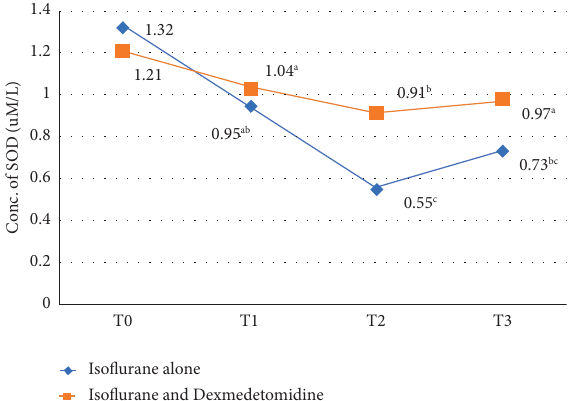
Figure 8: Comparison of enzymatic activity of SOD ( µ M/L) in group A and group B. T T 1 � at 4hours after anesthesia induction. T 2 � at 8hours of anesthesia induction, T 3 � at 16 hours of anesthesia induction. Superscripts (a, b, and c) shows the statistical diference among diferent time intervals between two